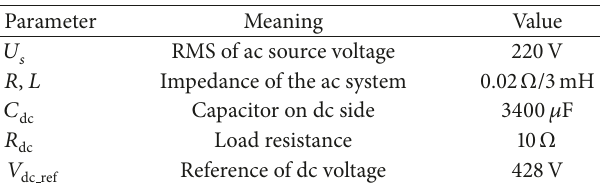
Table 1: Simulation parameters.